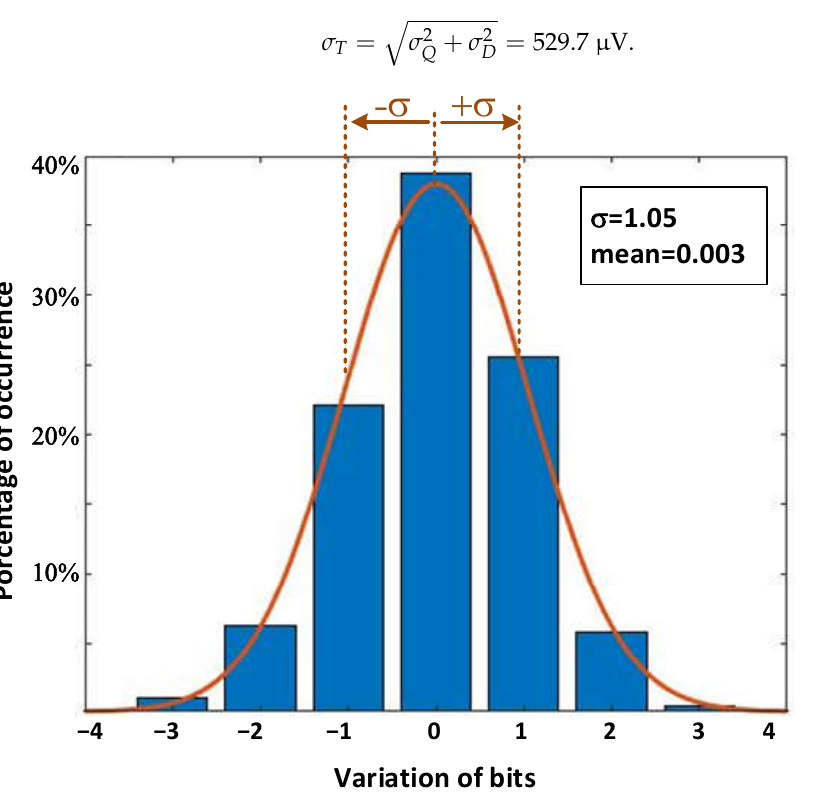
Figure 3. Histogram of the DC-noise of the XADC of the used FPGA.